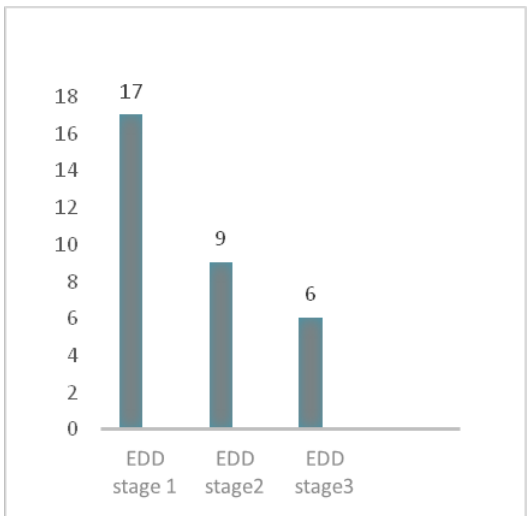
Figure 1. The frequency of different stages of EDD index in patients Twenty- three (72%) patients had the MMRC grades 2 and 3. There was statistically significant moderate correlation between Warrick score and the age of the patients (r= 0.45, P= 0.01).